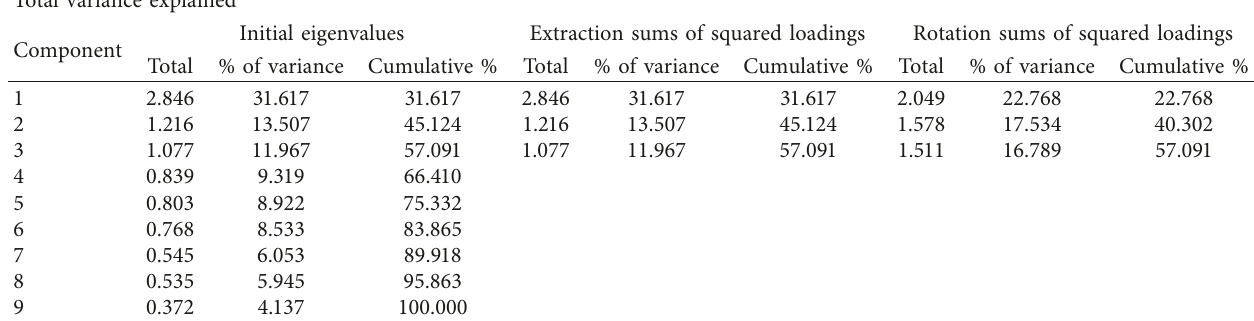
Table 8: Factor extraction and total variance